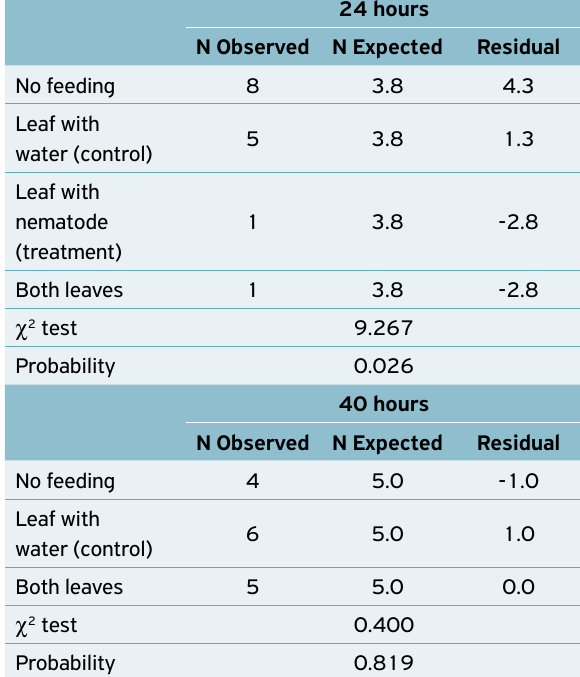
Table 3. Leaves of lettuce consumed by Gryllus sp. with chance of choice between leaves treated with Steinernema carpocapsae All and control treatment (with water) after 24 and 40 hours.